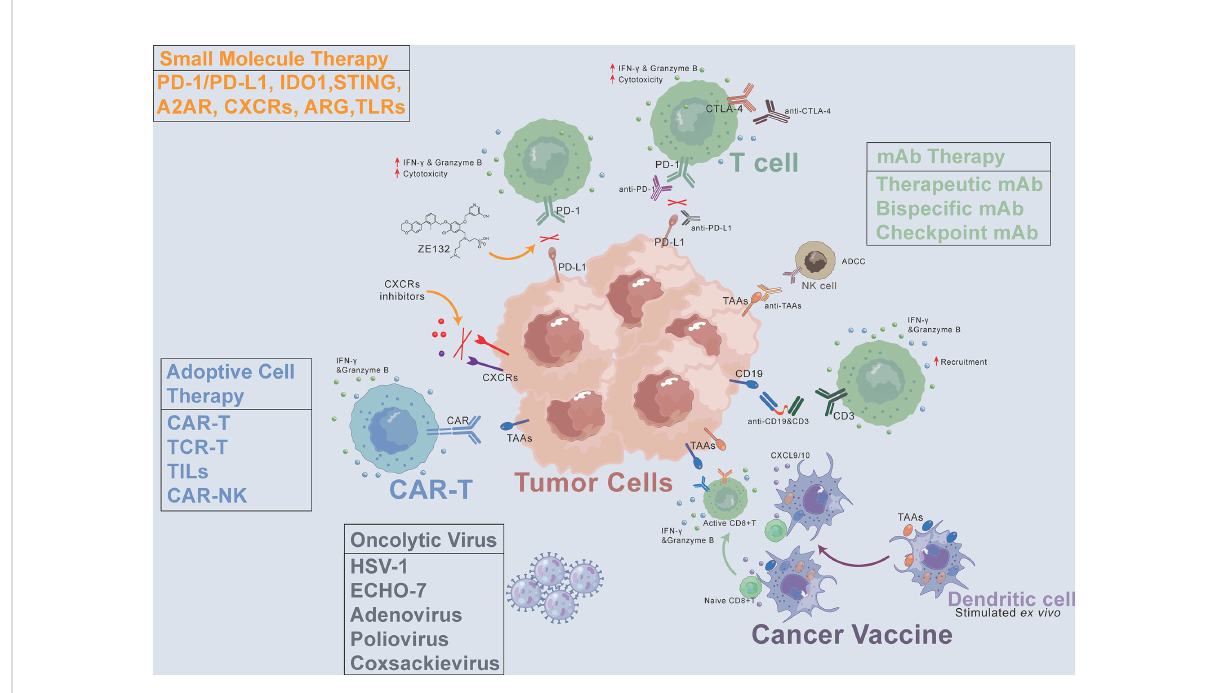
FIGURE 1 Cancer immunotherapy methods, including monoclonal antibodies (mAbs), small molecule drugs, adoptive cell therapy, oncolytic virus, and cancer vaccines. CAR, chimeric antigen receptor. CXCR, C-X-C motif chemokine receptor. TAAs, tumor-associated antigens. ADCC, antibody- dependent cell-mediated cytotoxicity. PD-1, programmed death-1. PD-L1, programmed death-ligand 1. CTLA-4, cytotoxic T-lymphocyte- associated protein